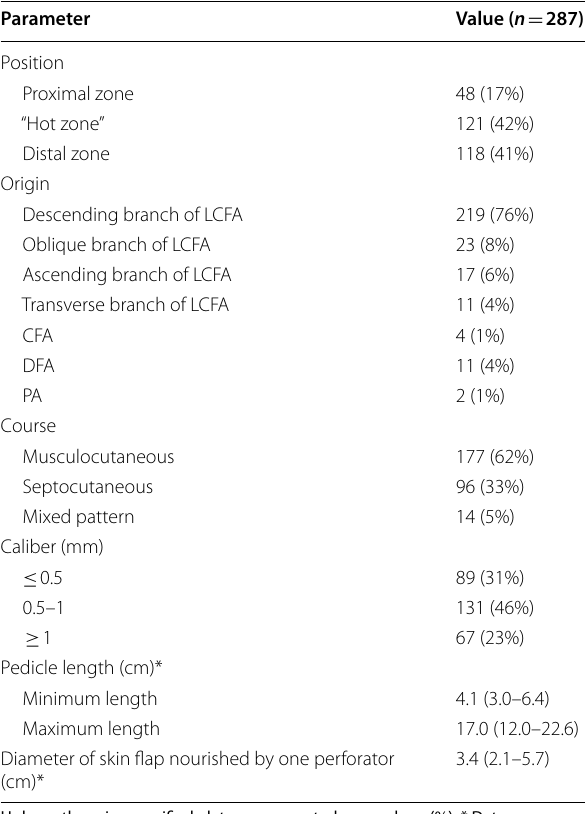
Table 3 Quantitative parameter of anterolateral